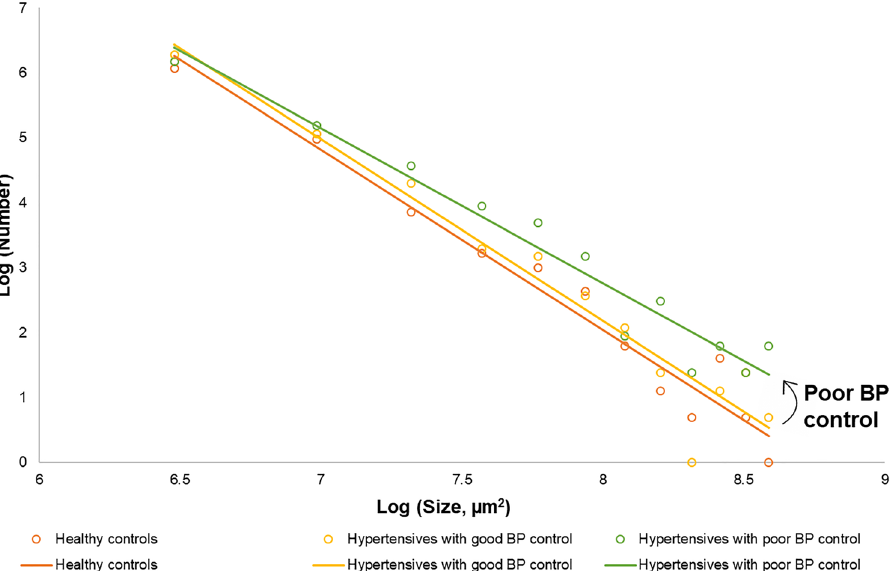
Figure 3. Schematic log–log plot concerning flow deficits where the data follow a y = mx + b slope intercept relationship between the number of flow deficits and size of flow deficits. Flow deficits that are larger regions, as shown along the right side of the slope, are more likely to occur in persons with poorly controlled blood pressure (BP).